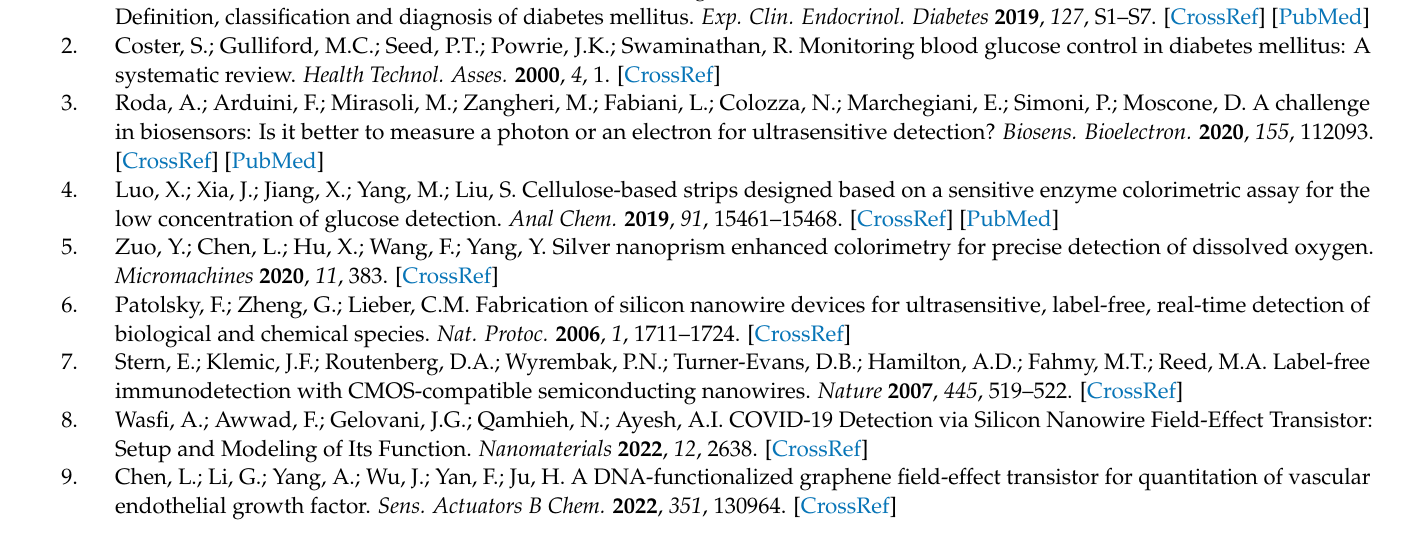
(b) An APTMS and Silane-PEG co-modified SiO 2 /Si area. (c) GA-modified SiO 2 /Si area. (d) A zone covered by GOD immobilized on the APTMS modified SiO 2 /Si surface. Figure S3: Transfer curve evolution of the SiNW-FET showing the GOD immobilization. Figure S4: XPS spectra and nitrogen peak assignment for amine-functionalized surface and GOD-functionalized surface.